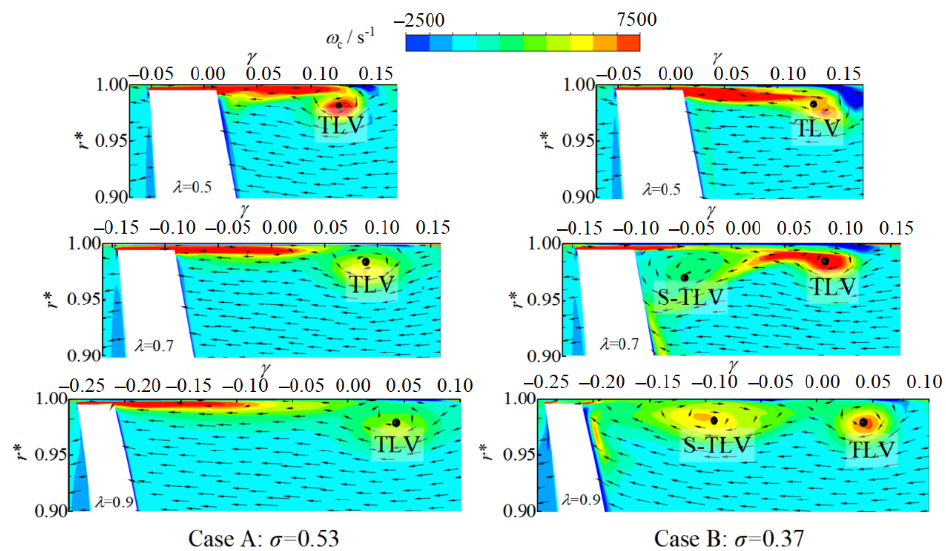
Figure 9. Distributions of circumferential vorticity on three planes.